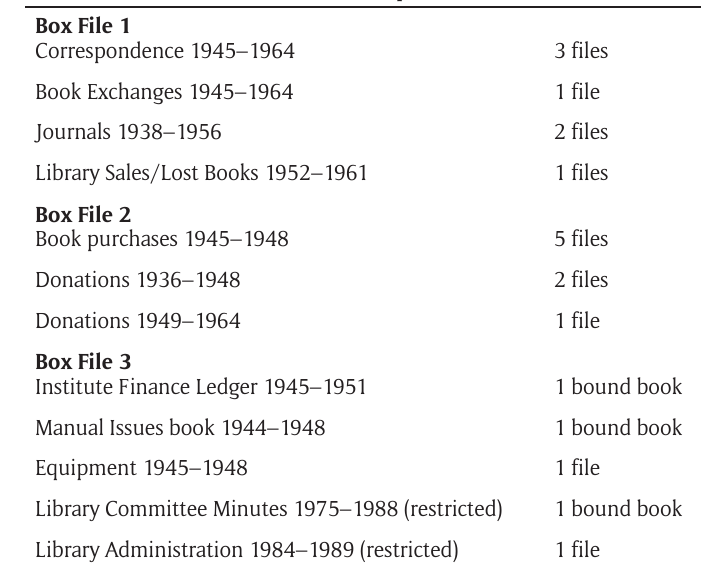
Table 1: Contents of Institute of Archaeology Library